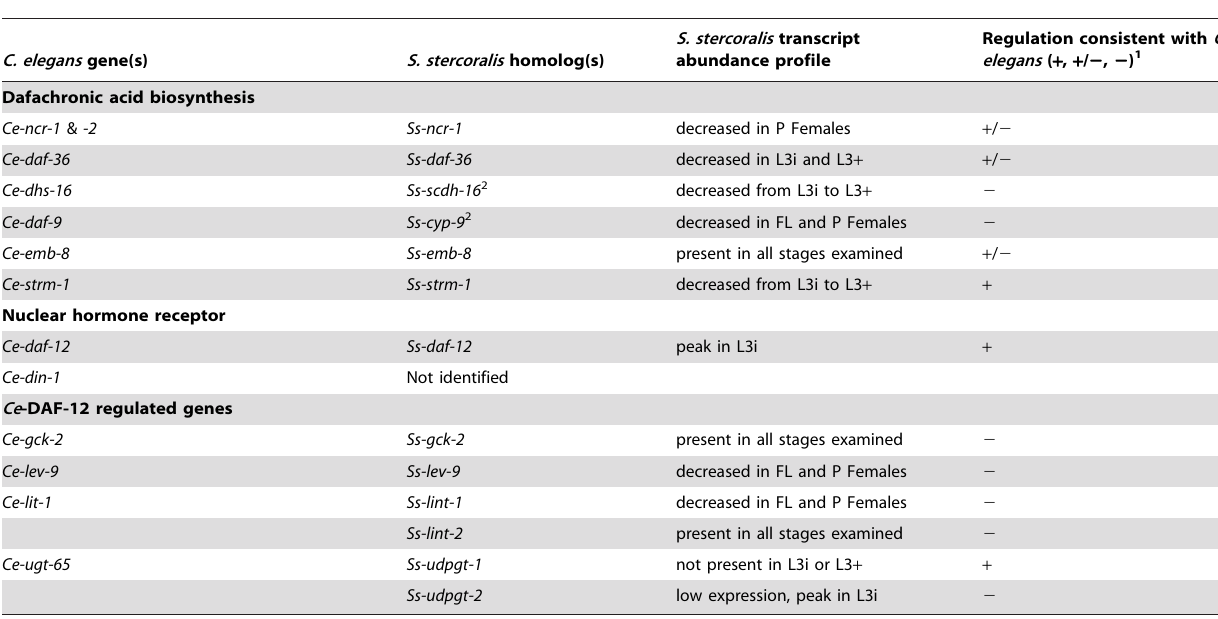
Table 4. Comparison of NHR pathway homologs and transcript abundances in S. stercoralis and C. elegans